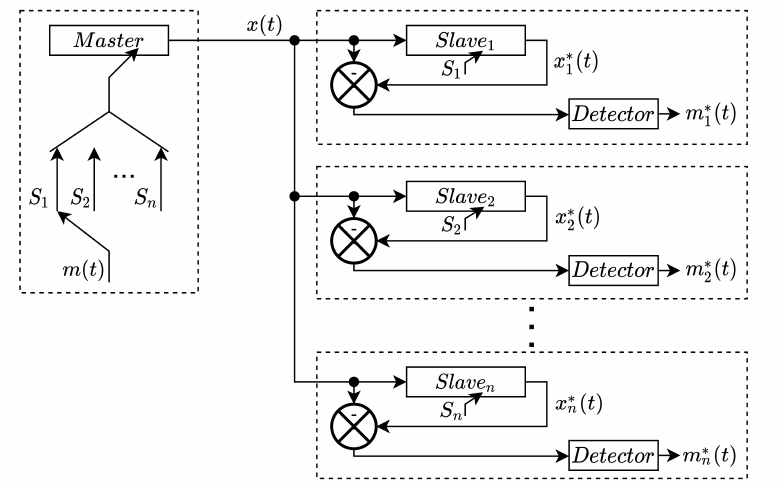
Figure 3. Block-diagram of one-to-many SCM communication system suitable for asynchronous binary coding with n